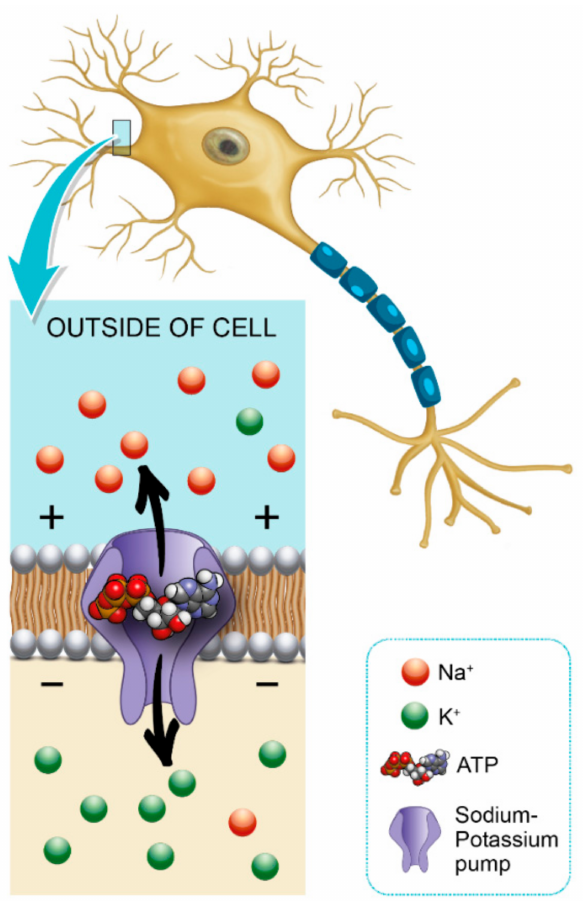
Figure 1. Role of hemoglobin A1c (HbA1c) in Na + /K + pump dysfunction and diabetic peripheral neuropathy (DPN)